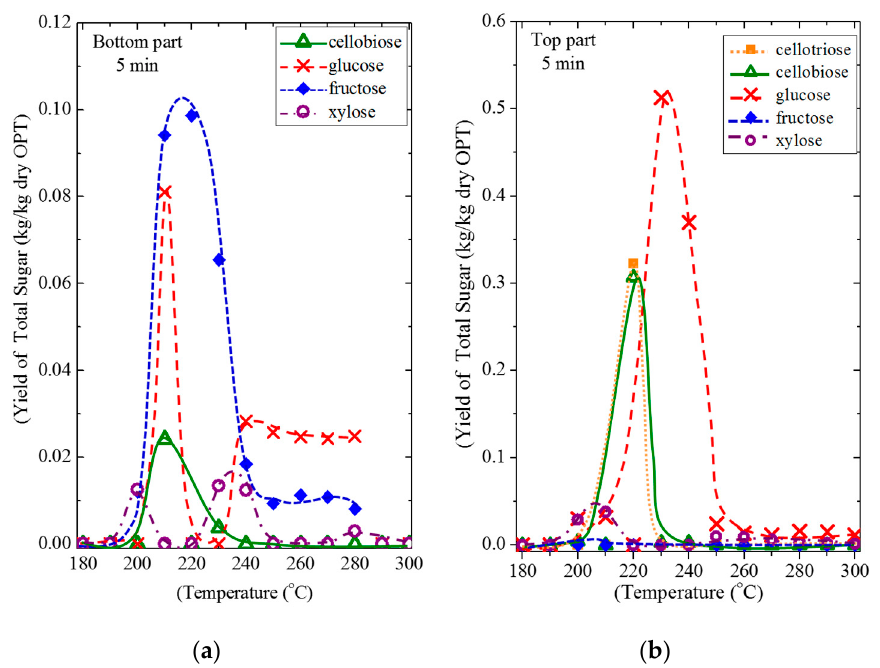
Figure 9. The effect of the reaction temperature on the yield of free sugar after OPT21 was subjected to sub-CW for 5 min. ( a ) bottom and ( b ) top sections.